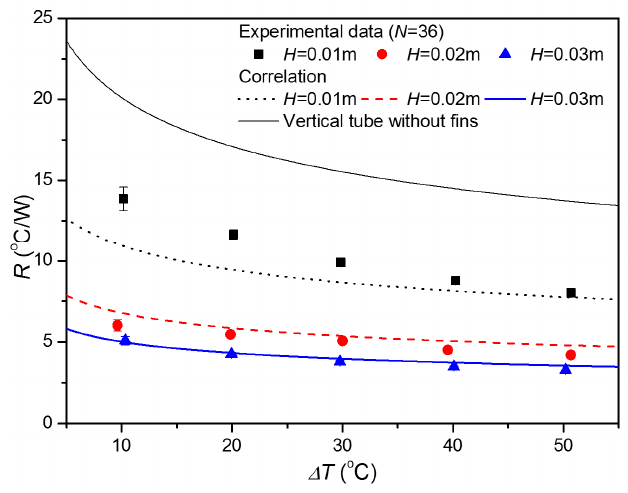
Figure 9. Effect of fin height on thermal resistance.